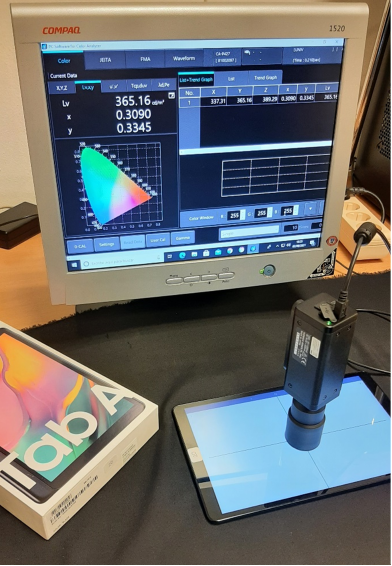
Figure 1. Measurement procedure. The screen of the tablet shows the reference stimulus for the colorimeter positioning. All measurements were performed in a darkened room. colorimeter positioning. All measurements were performed in a darkened